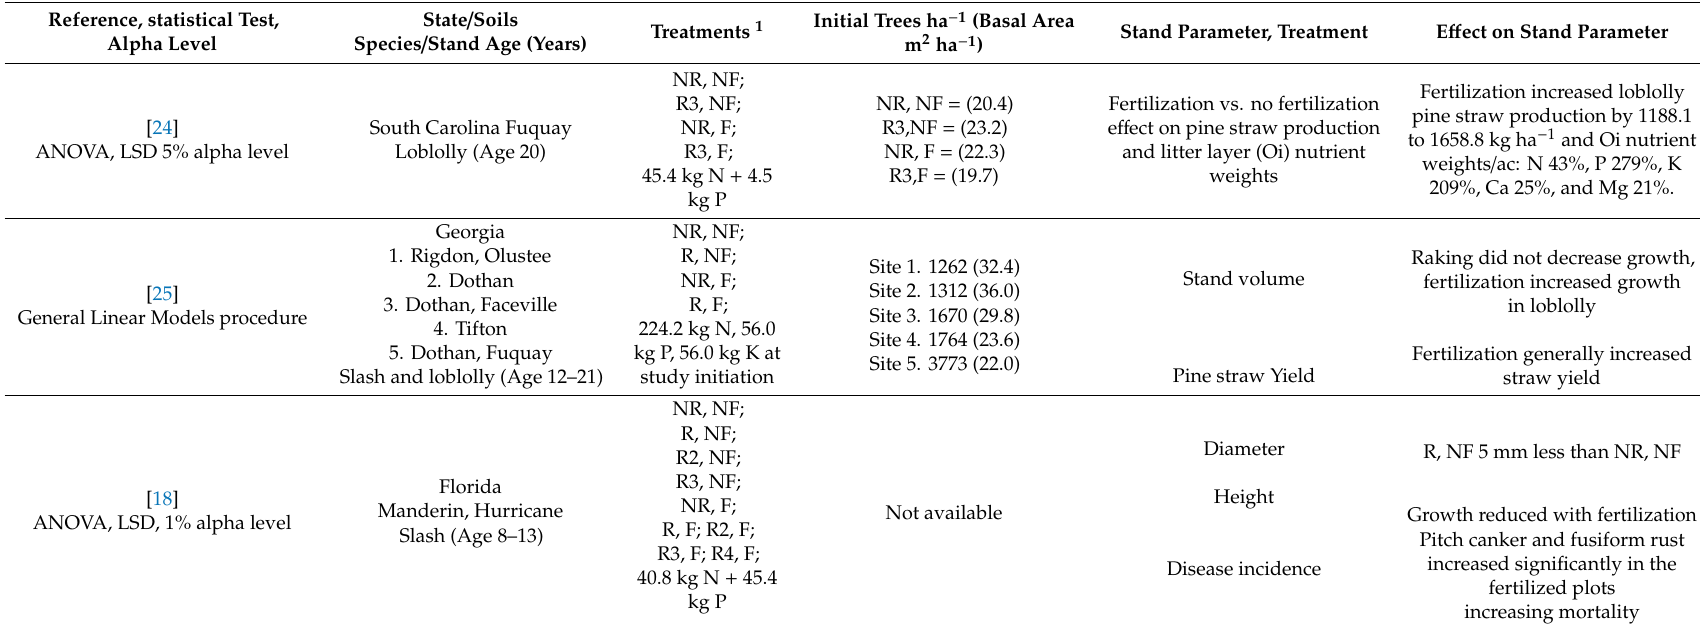
Table 6. E ff ects of pine straw raking and fertilization on loblolly and slash pine stand